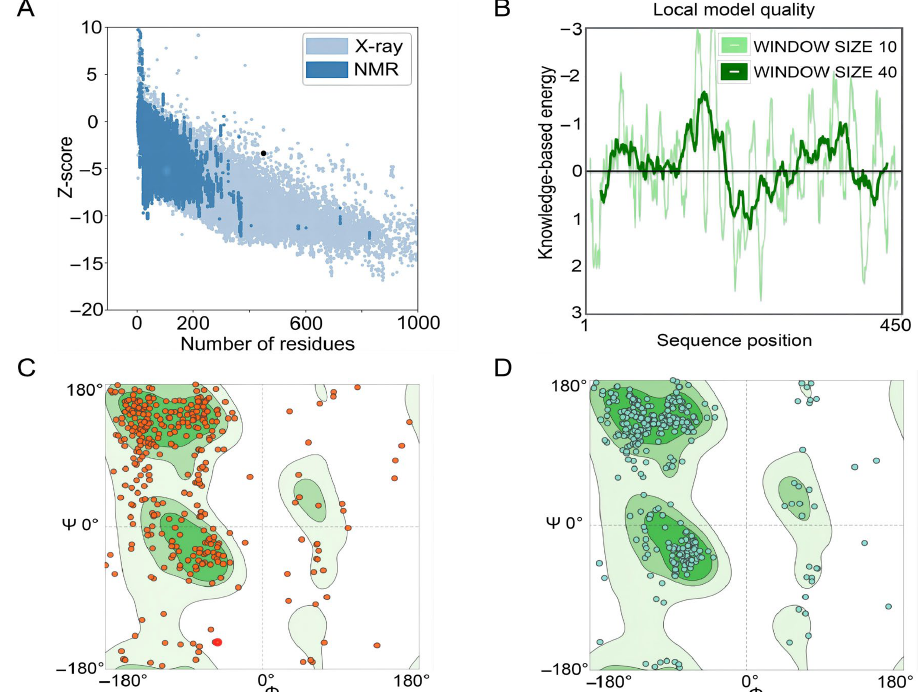
Figure 3. Evaluation and validation of tertiary structure models of the S7D5L4 vaccine. ( A ) The ProSA web server provided a Z-score of −3.36. ( B ) Tertiary structure energy map of S7D5L4 validated by the ERRAT web server. ( C ) The Ramachandran plot shows the following composition: favored region, 65.62%; outlier region, 13.84%; and rotamer region, 14.85%. The favored, outlier, and rotamer regions were shown in dark green, green, and light green, respectively. Amino acid residues before optimization were indicated by red dots. ( D ) The optimized Ramachandran plot shows the following composition: favored region, 81.03%; outlier region, 4.24%; and rotamer region, 0.61%. The favored, outlier, and rotamer regions were shown in dark green, green, and light green, respectively. Amino acid residues after optimization were indicated by blue dots.